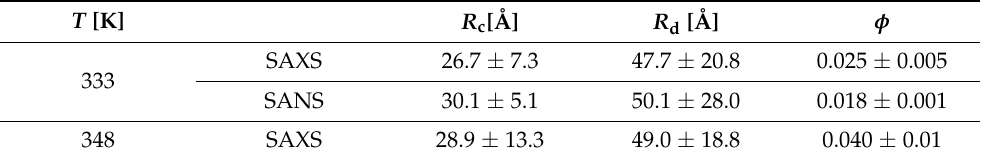
Table 5. The mean sphere cluster radius R c , the Percus–Yevick correlation radius of clusters R d and the volume fraction of spherical clusters ( φ ), fit parameters obtained using the Percus–Yevick approximation to the PEG-upy small angle scattering data at T = 333 K and T = 348 K.